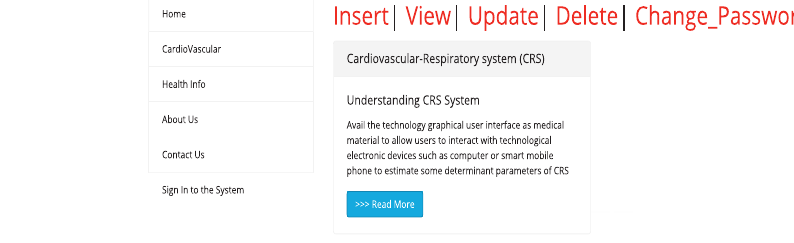
Figure 9: Admin page.